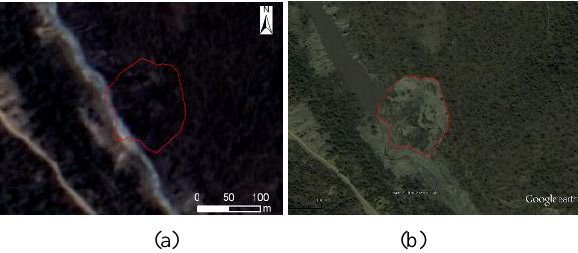
Figure 6. The Pisang landslide. (a) ZY3 satellite image taken on April 27, 2015; (b) Digital Globe satellite image from Google Earth taken on May 21, 2015